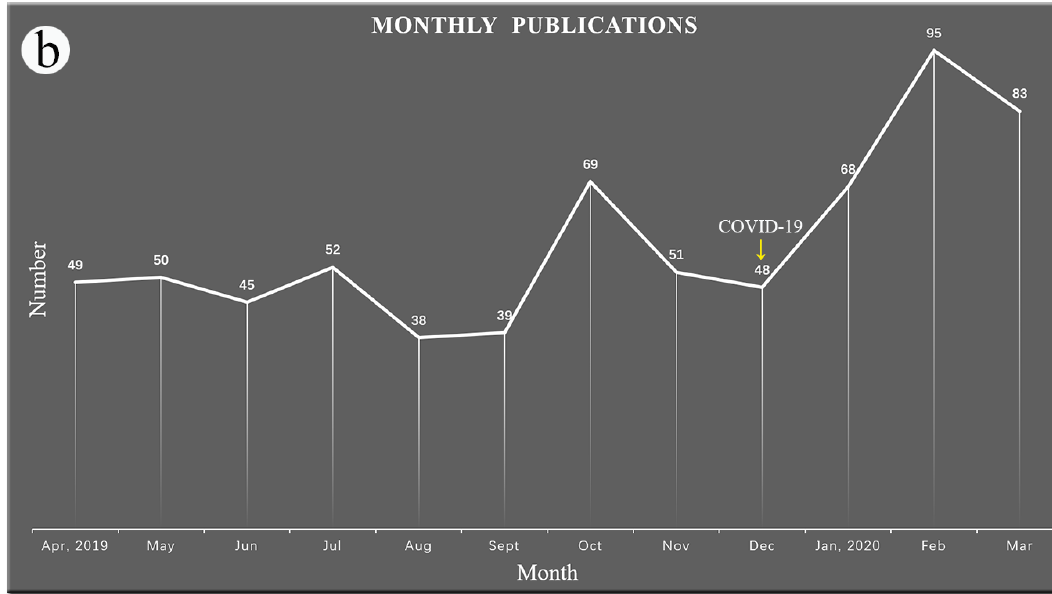
Figure 2. The time-related publications variation. Yellow arrows direct the key time points of SARS (severe acute respiratory syndrome), MERS (Middle East respiratory syndrome), and COVID-19 (coronavirus disease 2019) outbreaks. ( a ) The number of annual publications from 2000 to 2020; ( b ) the monthly publications from April 2019 to March 2020.